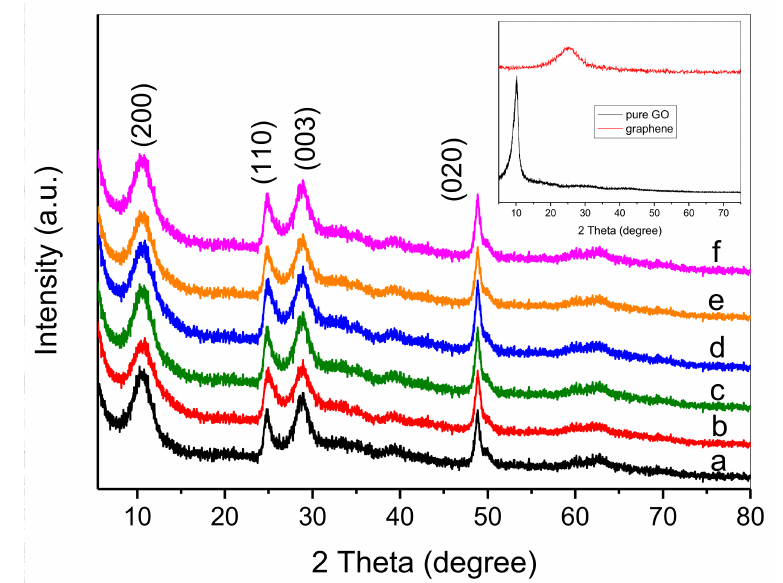
Figure 1. XRD patterns of hydrogen titanate nanotube (HTT)/graphene nanocomposites: (a) pure HTT, (b) HTT/graphene-0.2%, (c) HTT/graphene-0.4%, (d) HTT/graphene-1.0%, (e) HTT/graphene-2.0%, (f) HTT/graphene-4.0%. Inset: XRD patterns of pure GO and